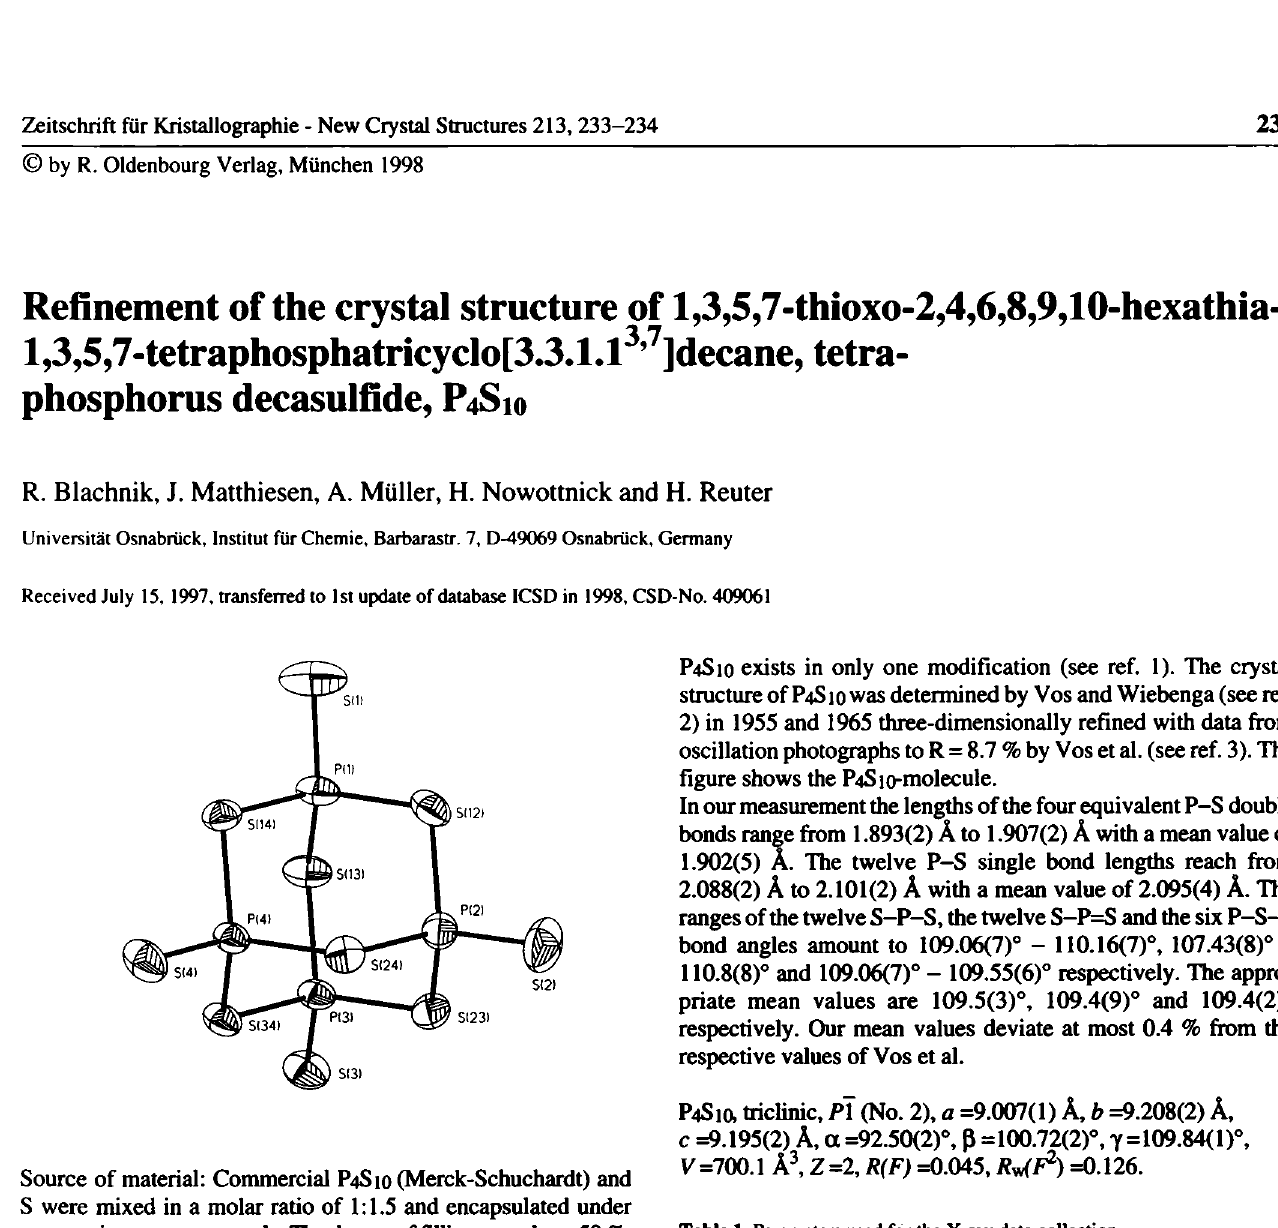
Table 1. Parameters used for the X-ray data collection Crystal: